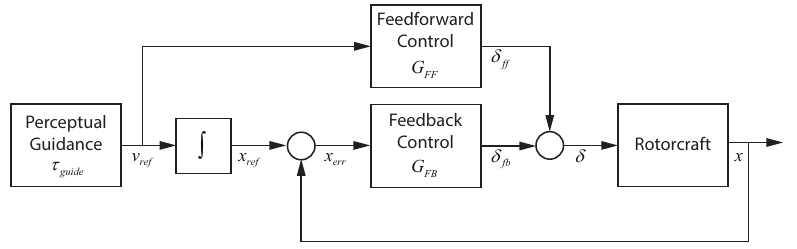
Figure 8. Structure of the visual tracking